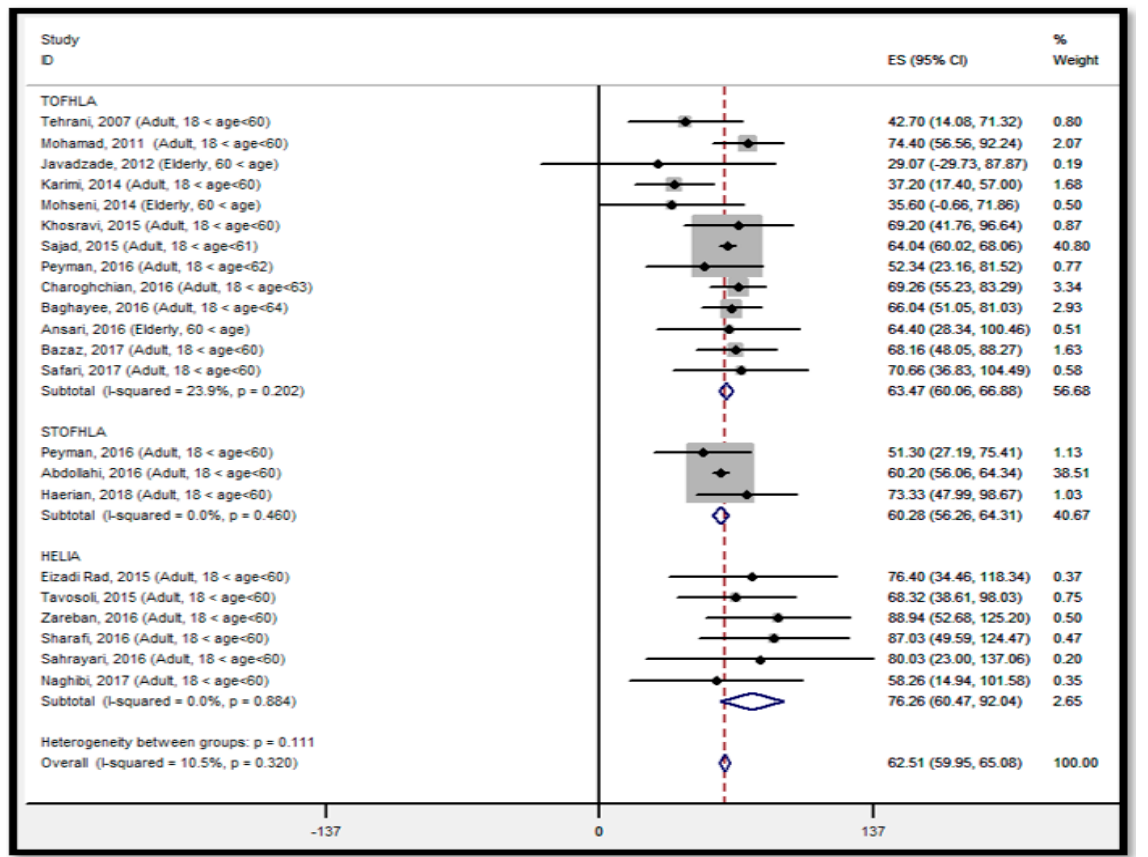
Figure 2. Forest plot of the distribution of effect size for health literacy status in populations with a health condition, stratified by type of instruments, ES: effect size, I 2 : a measure of the ratio of the total variation in study measures due to heterogeneity, p > 0.05: devastates heterogeneity is appropriate for interpretation.